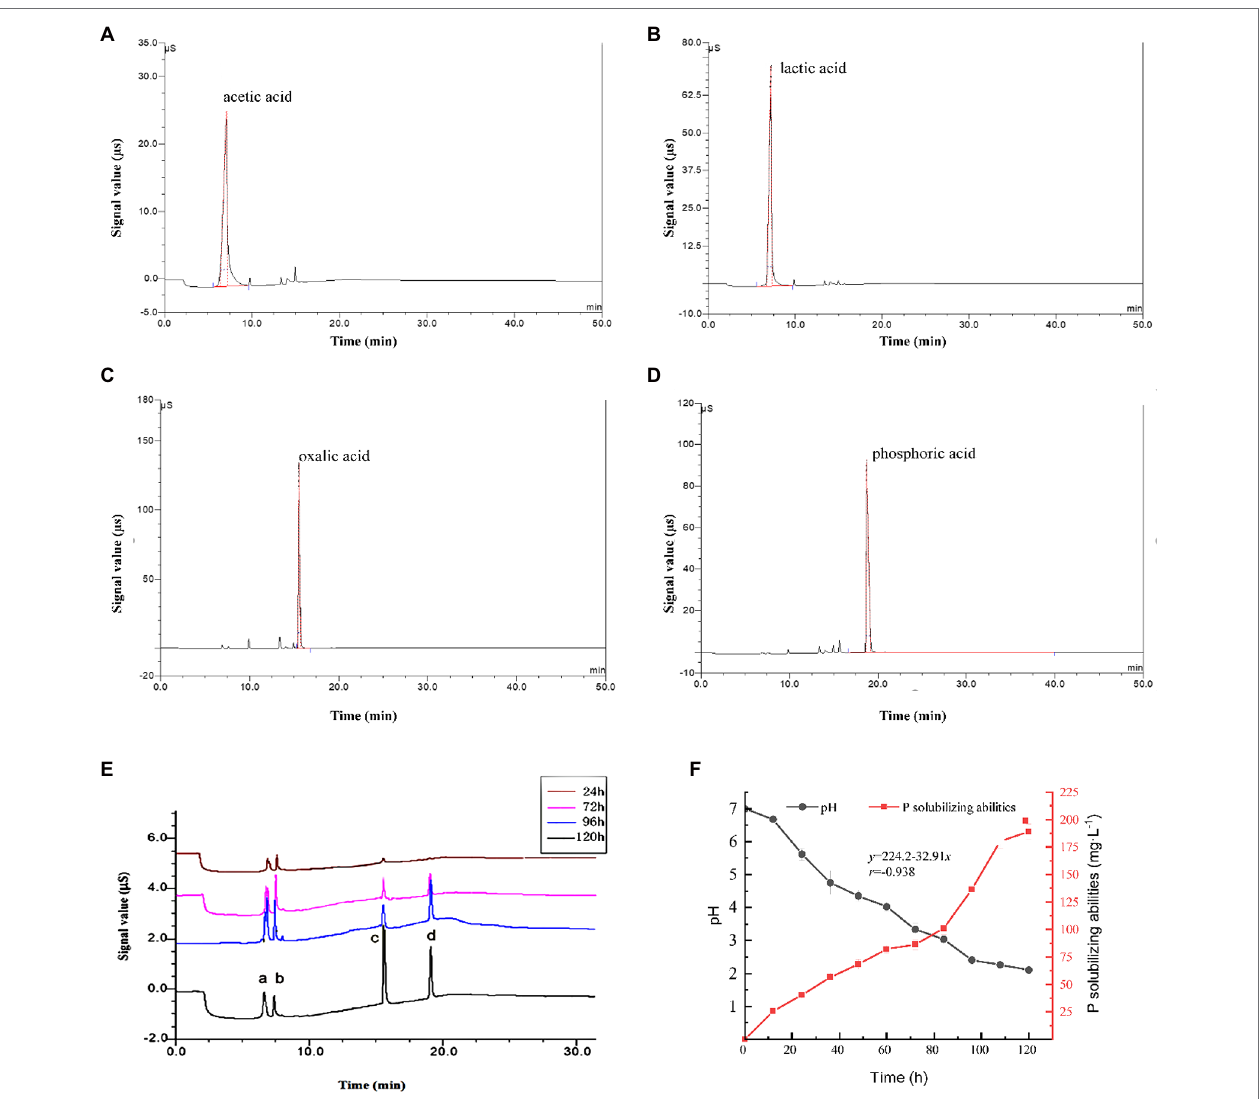
FIGURE 3 | Penicillium oxalicum F9 phosphorus-solubilizing ability. (A–D) . The ion chromatograms of lactic acid, acetic acid, oxalic acid, and phosphoric acid standard samples, respectively. (E) Ion chromatography of P. oxalicum F9 culture medium during growth, a, b, c, and d is lactic acid, acetic acid, oxalic acid, and phosphoric acid, respectively. (F) Culture medium pH and P-solubilizing capacity of P. oxalicum